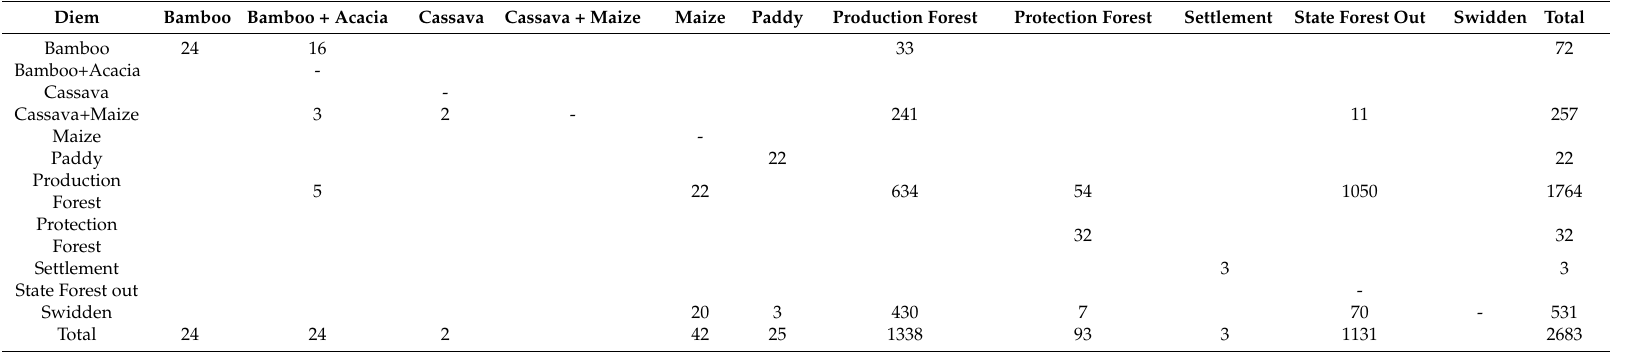
Table A3. Land-use change matrix; based on participatory mapping on 3D maps for the years 2000 and